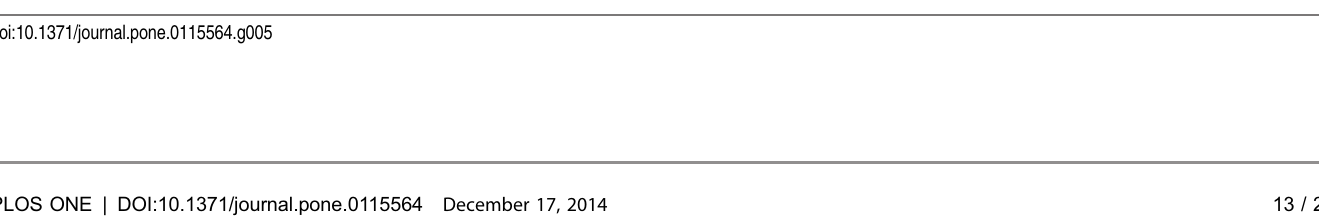
Fig. 5. Immunohistological staining for neutrophils, macrophages and Ym1-positive cells on days 3 and 7. (A) Neutrophils (arrows) stained with anti- neutrophil antibody, (B) macrophages (arrows) stained with anti-Mac-3 antibody and (C) Ym1-positive cells (arrows) stained with anti-Ym1 antibody were observed in wound tissue on days 3 and